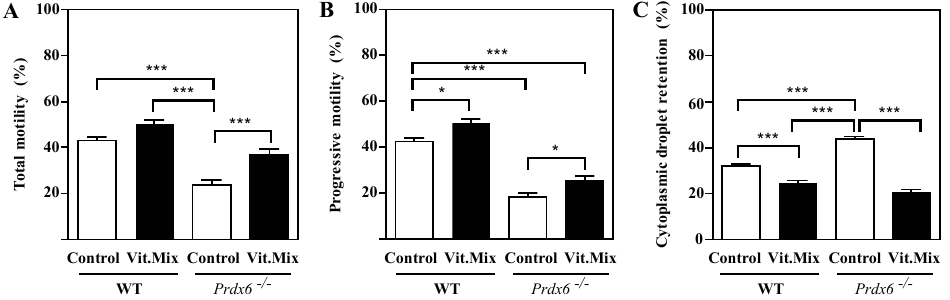
Figure 4. Motility and epididymal maturation of spermatozoa from WT or Prdx6 ‐ / ‐ males fed with the control (open bars) and Vit. Mix (black bars) diets, respectively. Total ( A ) and progressive ( B ) motility and (C) cytoplasmic droplet retention, a marker of immature spermatozoa. * p ≤ 0.05; *** p ≤ 0.001, two ‐ way ANOVA and Tukey tests.